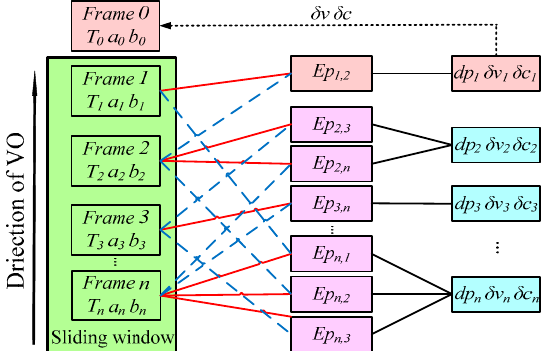
Figure 4. The factor graph of the direct formulation. The tracked pixel of the host frame is represented by the solid red line, which is linked to co-visual frames by the dotted blue line. For each term of the tracked pixel, an energy function of the residual was established to calculate the inverse depth and photometric parameters, which are shown by the black line. Then, the parameters were utilized to compensate the next frame.